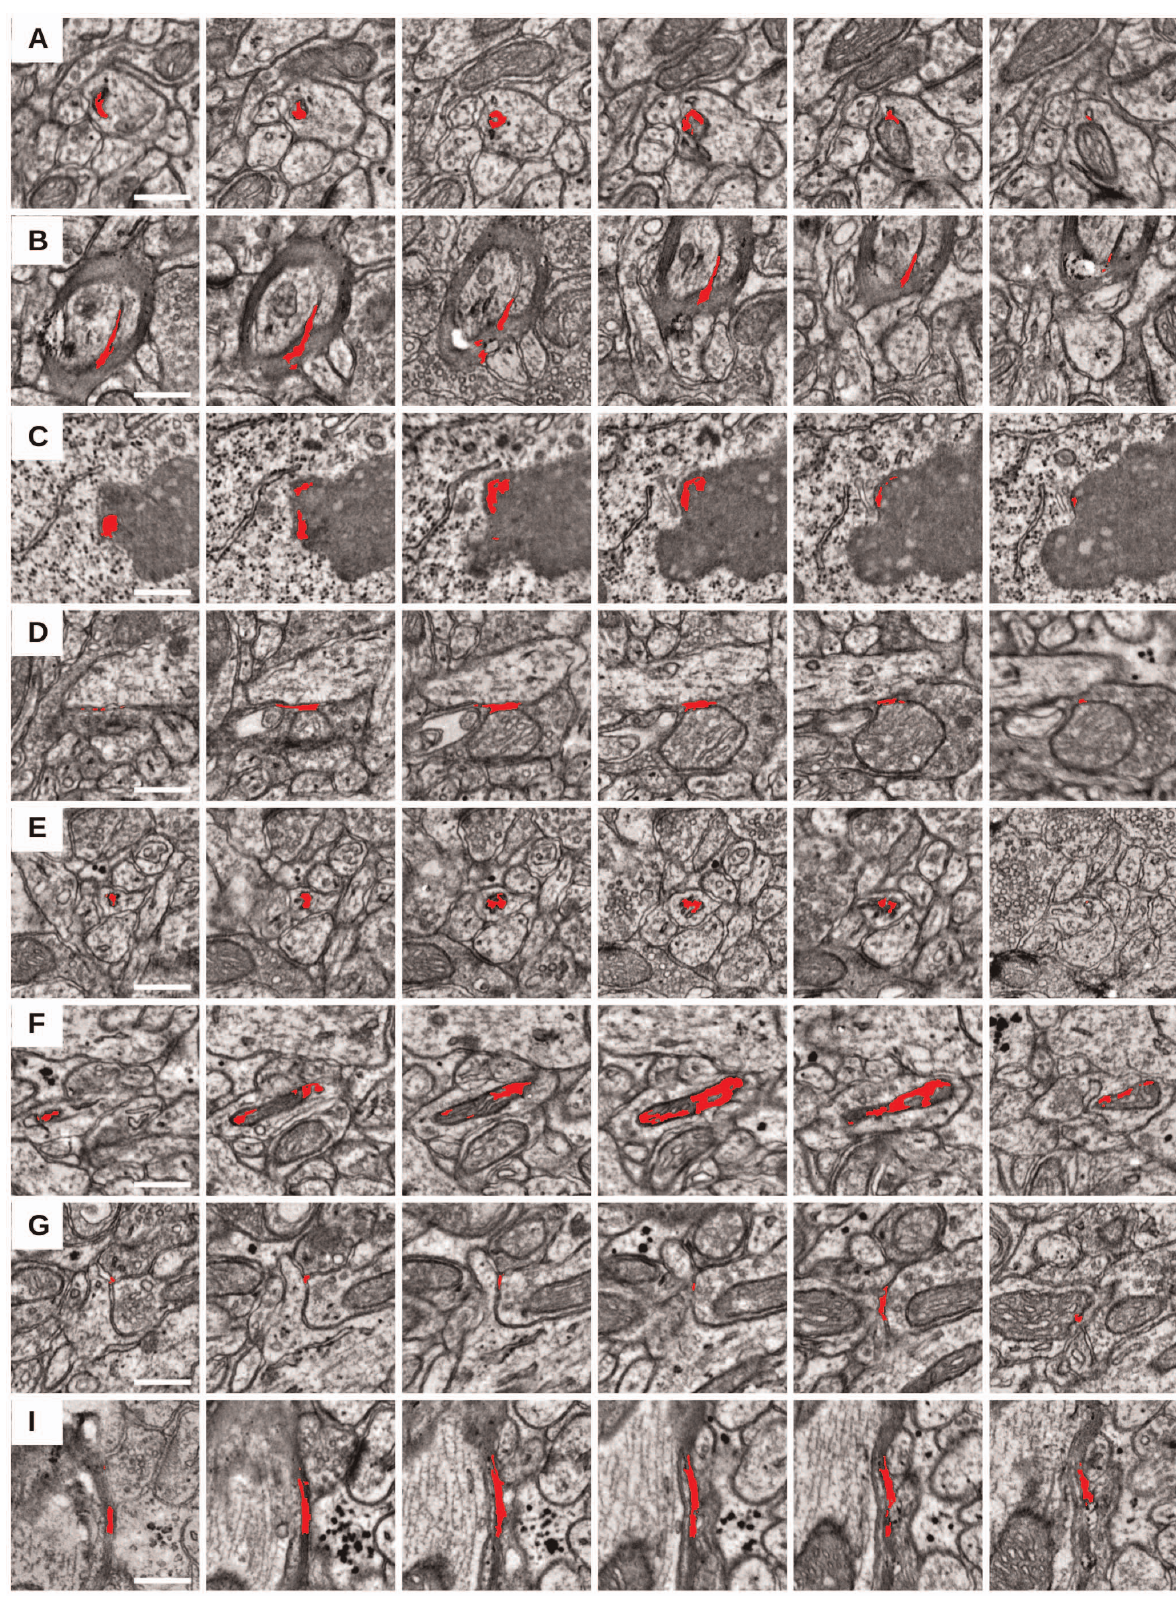
Figure 4. Examples of false positive detections. All scale bars – 450 nm, every second slice is shown (distance between consecutive images is 90 nm).